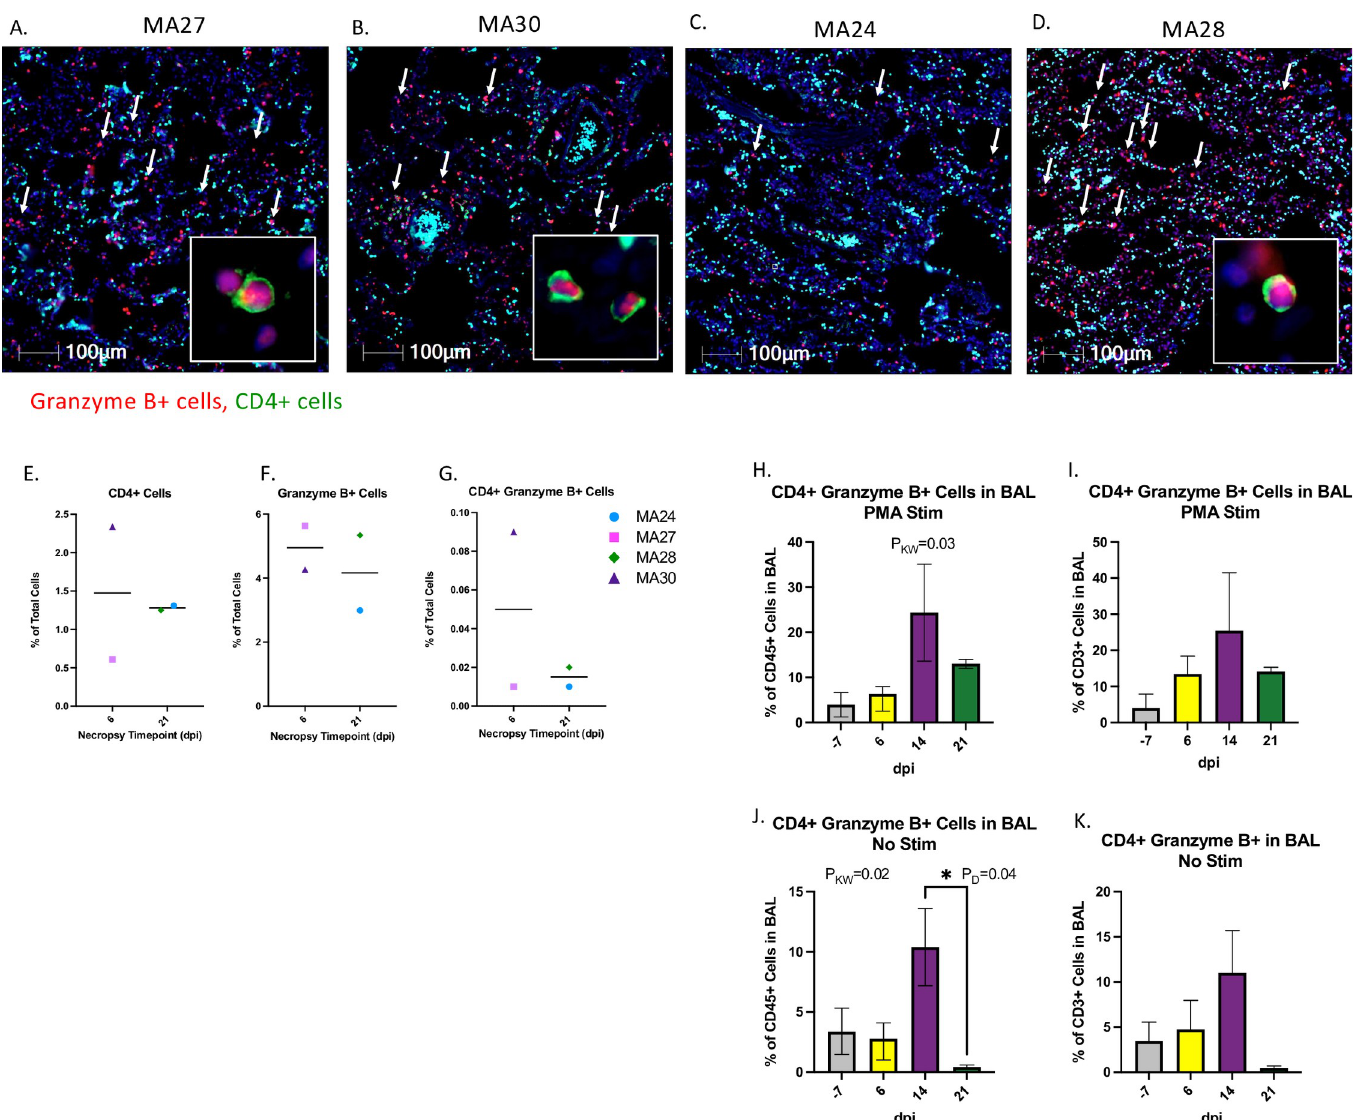
Fig 9. CD4 and Granzyme B expression in the lungs of SARS-CoV-2 infected macaques at 6- (A and B) and 21-days post infection (dpi, C and D ). At 6-dpi, MA27 (A) and MA30 (B) the lungs are infiltrated by large numbers of Granzyme B positive cells (red, arrows). Insets: Rare CD4+ cells (green) exhibit granzyme expression. At 21-dpi, MA24 (C) exhibits low numbers of Granzyme B positive cells (red, arrows) compared to MA28 (D) and the two, 6-dpi animals (A and B). DAPI = Blue, Green = CD4, Red = Granzyme B. E-G. Percentage of CD4+ (E), Granzyme B+ (F) and CD4+ Granzyme B+ (G) cells in the lung at necropsy. Bars represent median. H-K. CD4+ Granzyme B+ T cells (CD45+ CD3+ CD4+ Granzyme B+) in BAL at Baseline (-7) and 6-, 14- and 21-dpi as a percentage of CD45+ cells (H and J) and CD3+ cells (I and K). H and I. Mononuclear cells, isolated from BAL, were stimulated with PMA/ionomycin for 4–6 hours. Bars represent median and standard deviation. Kruskal- Wallis comparison of overall means (P KW ) and Dunn’s Multiple comparisons (designated by line, P D ) tests used to determine significance. P values � 0.05 reported. Panels H-K. Baseline: n = 3 (No Stimulation (Stim)) and n = 2 (Stim), Day 6: n = 4 (No Stim) and n = 4 (Stim), Day 14: n = 2 (No Stim) and n = 2 (Stim), Day 21: n = 2 (No Stim) and n = 2